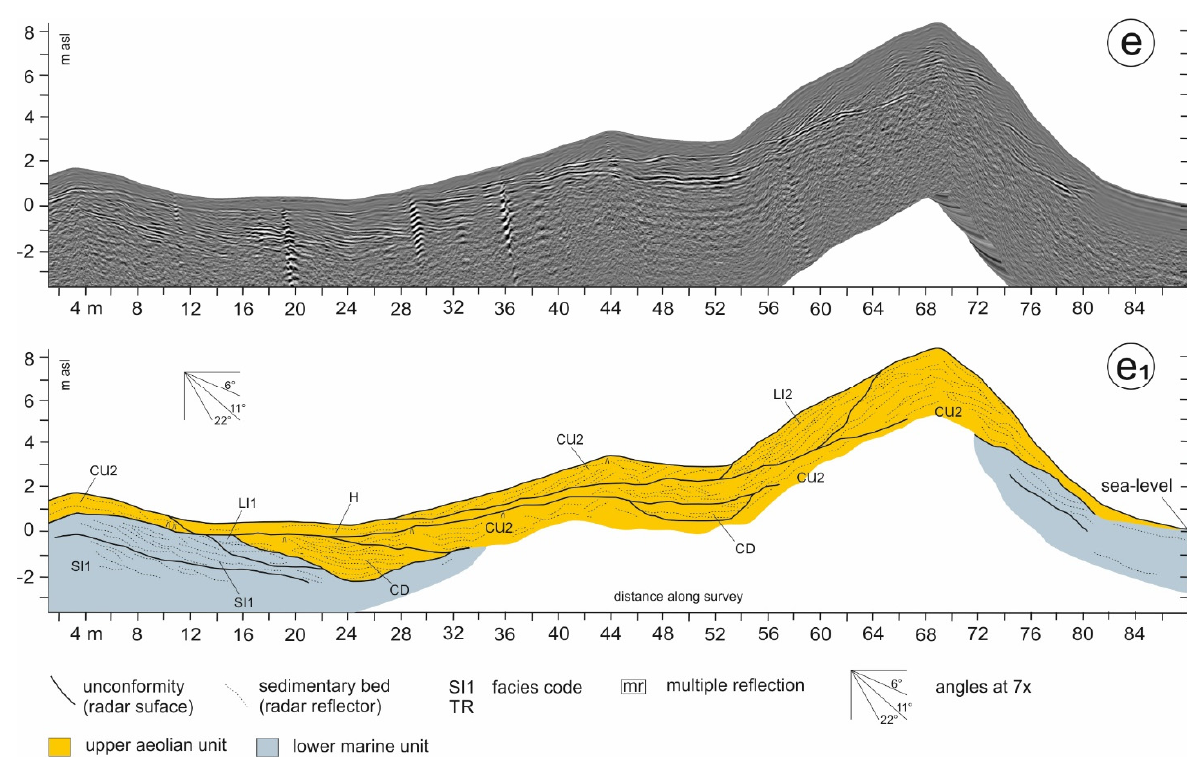
Figure 8. Processed ( e ) and corresponding interpreted ( e 1 ) GPR profile. For profile location see Figure 2. Figure 6. Processed ( a , b , c , d , e ) and corresponding interpreted ( a 1 , b 1 , c 1 , d 1 , e 1 ) GPR profiles. For profiles location see Figure